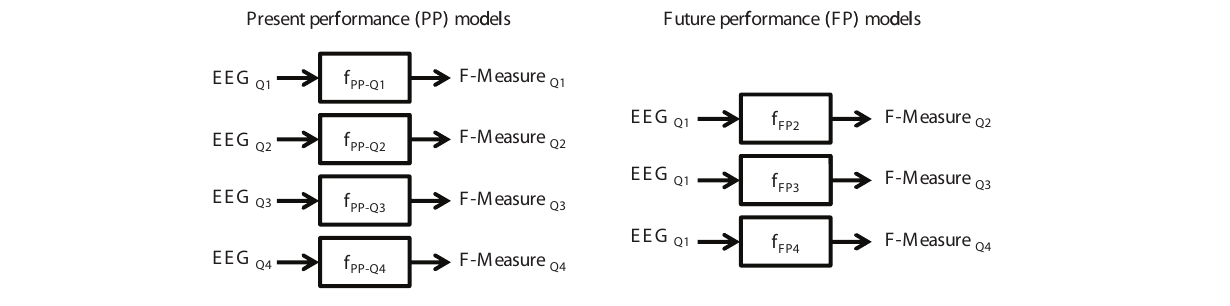
Figure 2 | input and output for the present performance (PP) and future performance (FP) linear regression